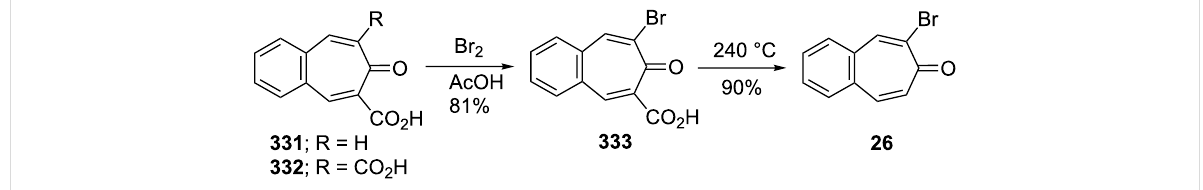
Scheme 57: Synthesis of 2-bromo-4,5-benzotropone ( 26 ).